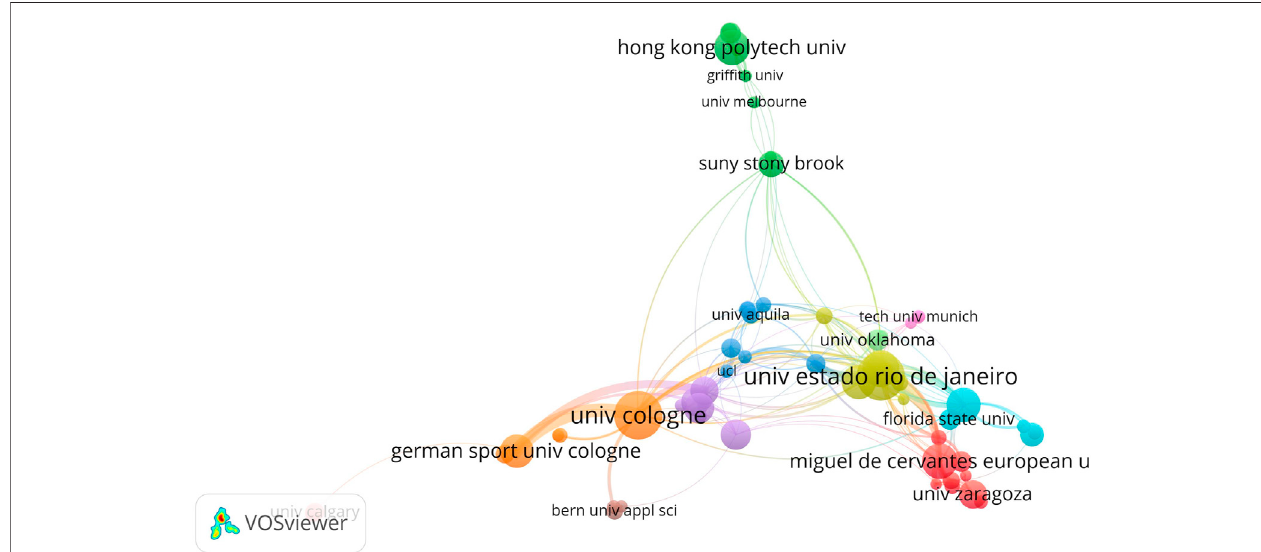
FIGURE 3 | Cooperation network of the organizations in the research of WBVT.